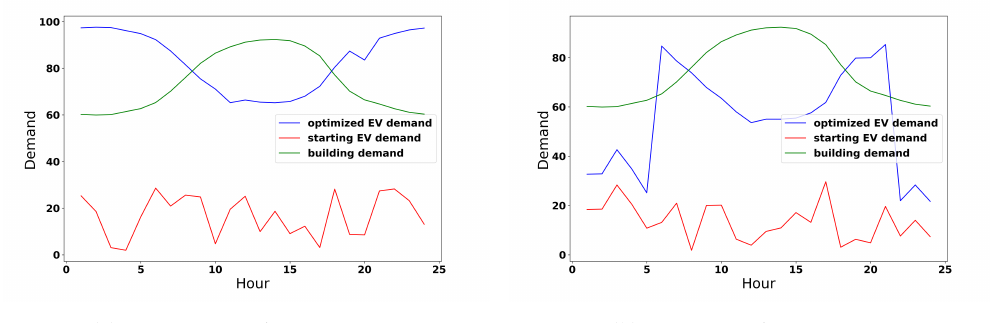
Figure 7. EV demand